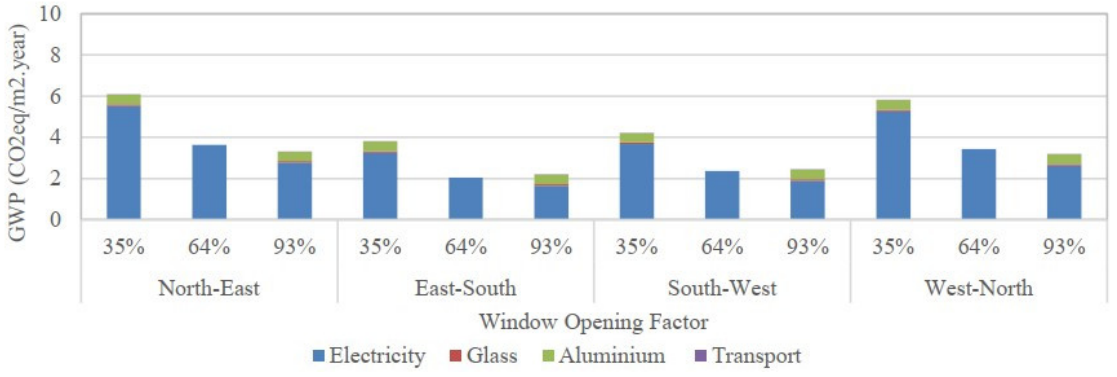
Figure 7. Global Warming Potential impact per m 2 · year – window opening factor